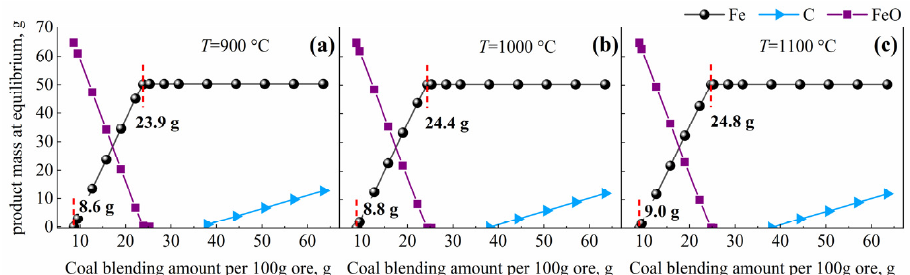
Figure 6. Composition and content of the equilibrium solid phase: ( a ) T = 900 °C; ( b ) T = 1000 °C; ( c ) T = 1100 °C.